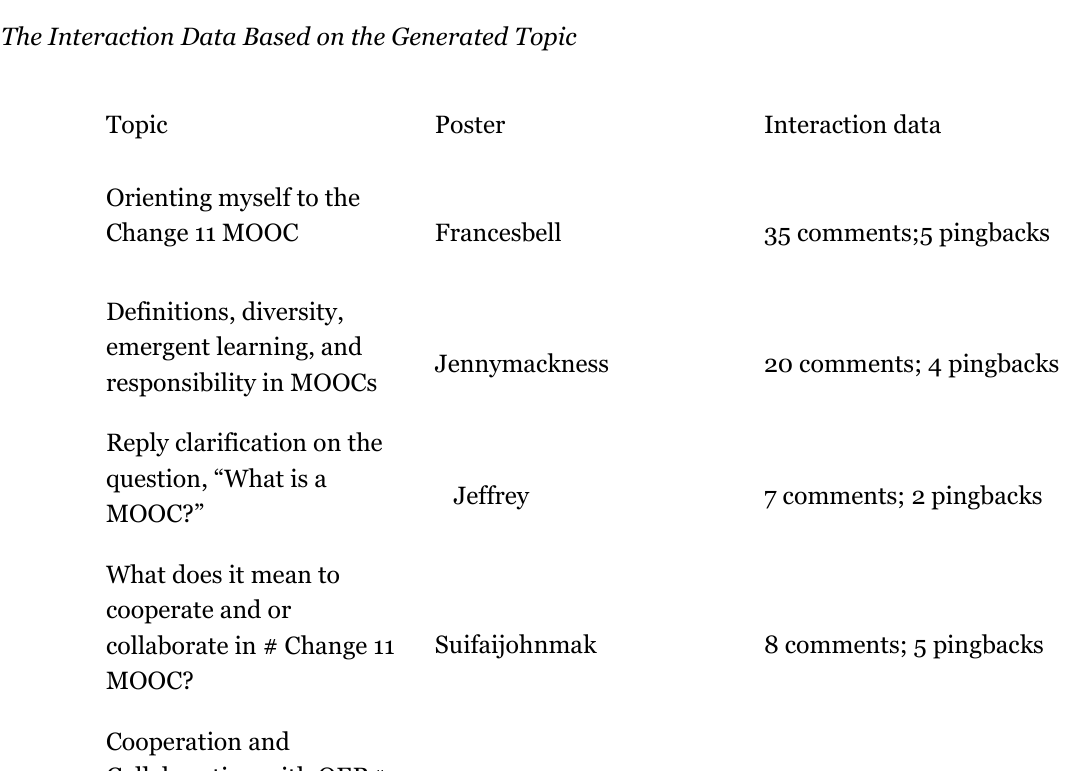
Table 5 The Interaction Data Based on the Generated Topic